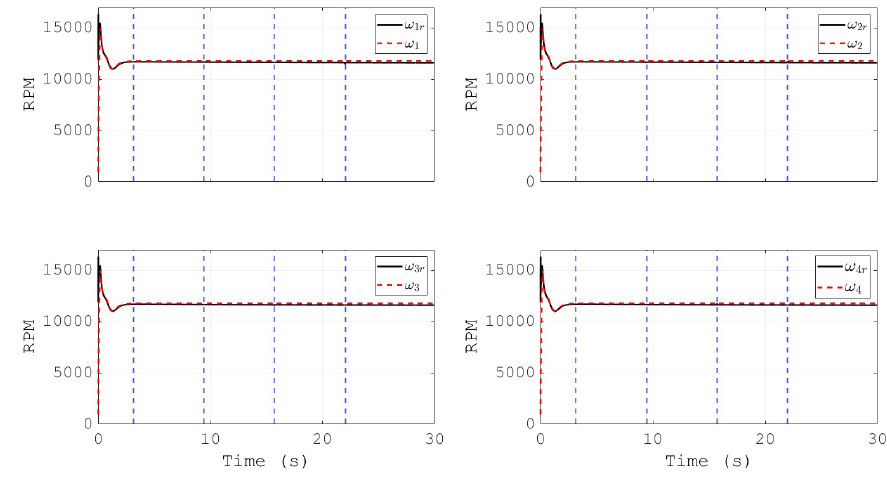
Figure 13. Commanded propellers velocities and their